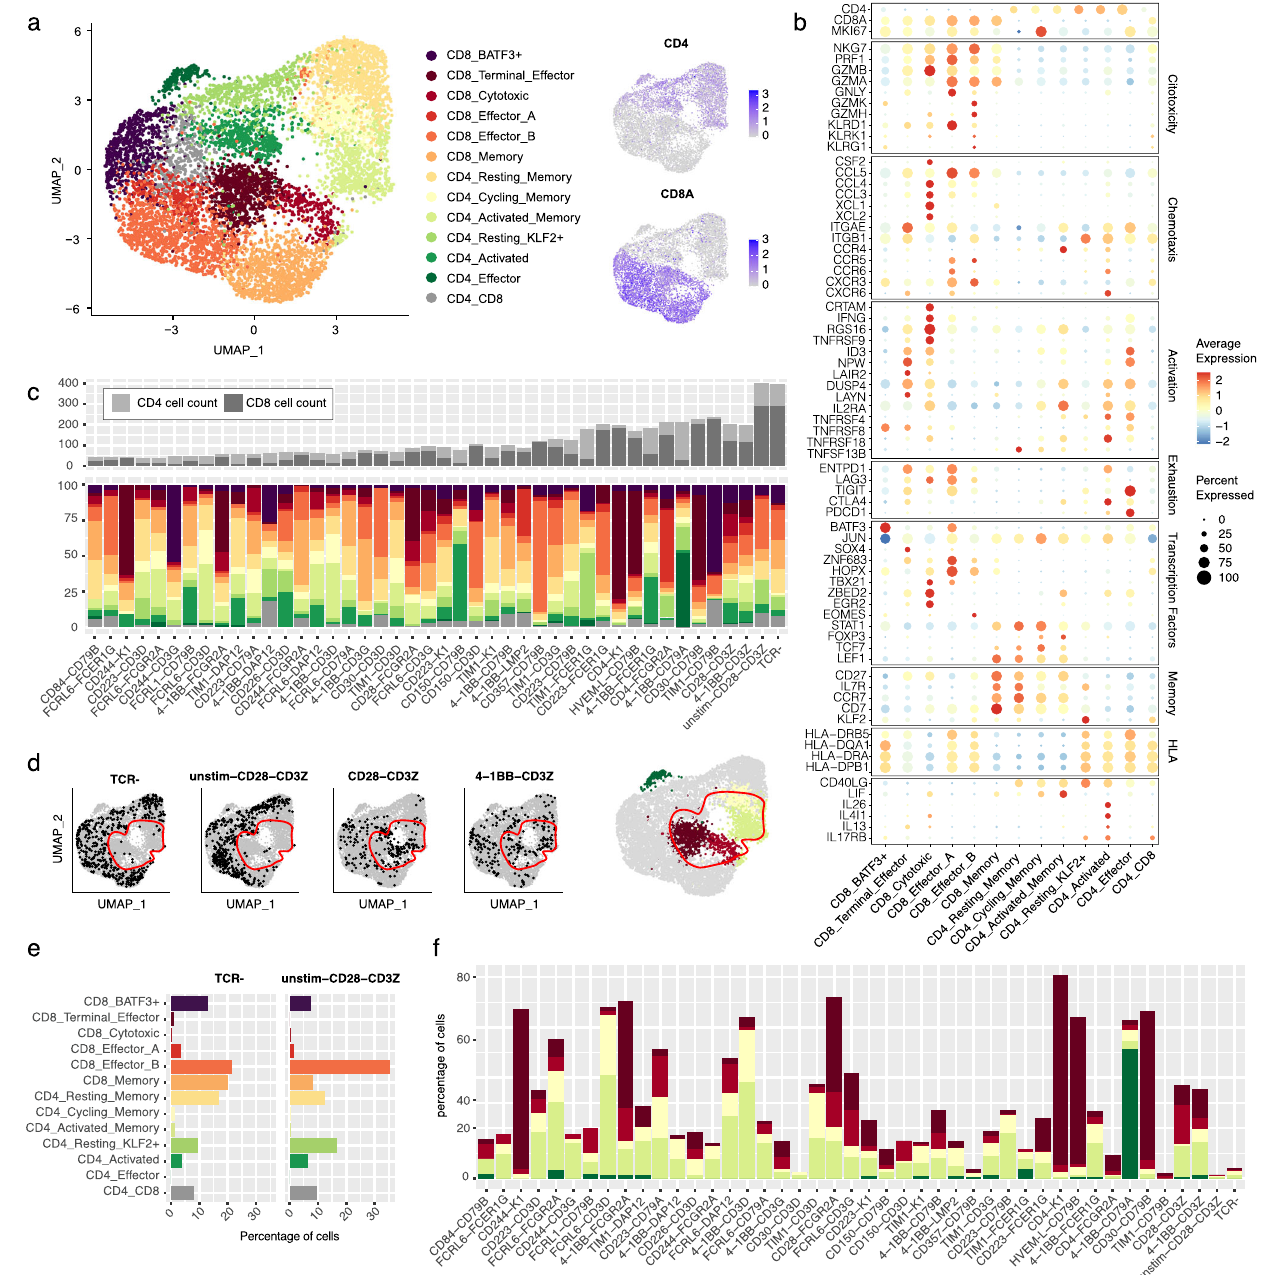
Fig. 2 | Unsupervised cell clustering classi fi es CAR variants based on distinct transcriptionalphenotypes.a UMAPembeddingandunsupervisedcellclustering based on scRNA-seq data of the pooled CAR T cell library following functional activation (co-culture with cognate antigen-expressing SKBR3 tumor cells). Shown are data from 7,244 variant-assigned CAR T cells with random subsampling restrictingittoamaximumof250cellsperCARconstruct.Inaddition,500cellsfor TCR-negative (TCR-) and unstim-CD28-CD3Z negative control samples were included.Ontheright, UMAPfeatureplotsshow thedistributionof CD4- and CD8- expressing cells. b Dot plot showing the expression of a selection of T cell marker genes across clusters found in a . Color and size indicate differences in expression levels between groups. c Cluster enrichment observed for the top 40 most repre- sented CAR variants (variants with at least 50 cells assigned), benchmark controls